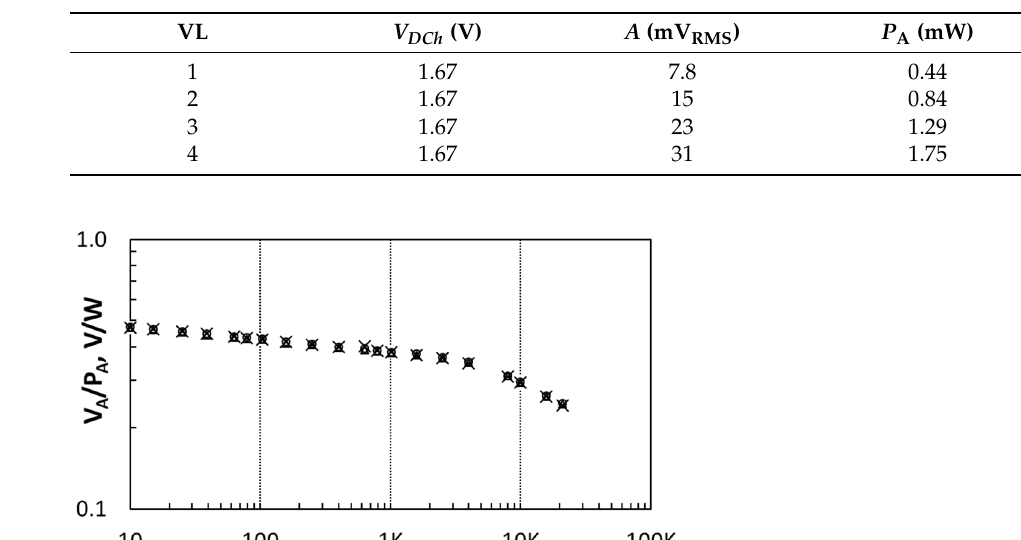
Table 2. Excitation applied to the heater.